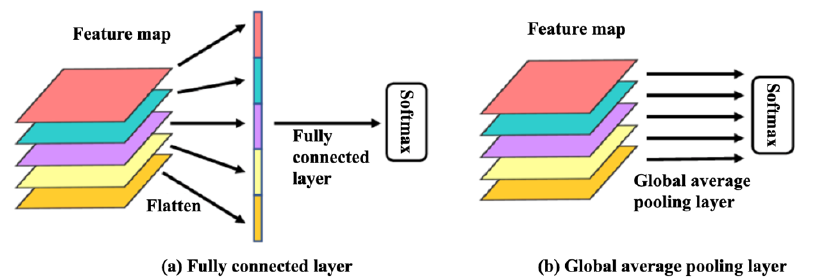
Figure 5. Comparison of the fully connected layer and global average pooling layer.